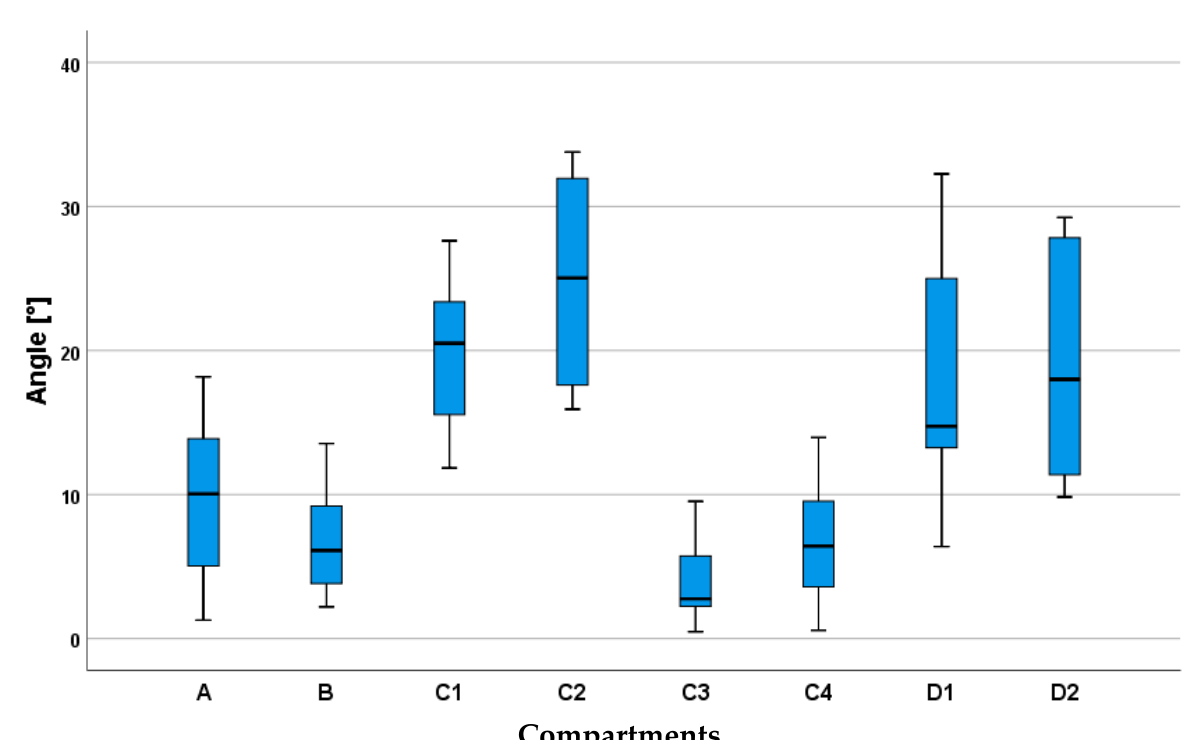
Figure 6. Pennation angles to the sagittal plane calculated for each compartment A – D and sub-compartment C1 – C4 and D1 and D2 . Angles above zero degrees describe fascicle orientation in a medial direction to the spine. The boxplot or box and whisker plot depicts the quartiles (2 quartiles in the box and 2 out of the box indicated by the whiskers) and the median (bold line in the box) of the distribution.